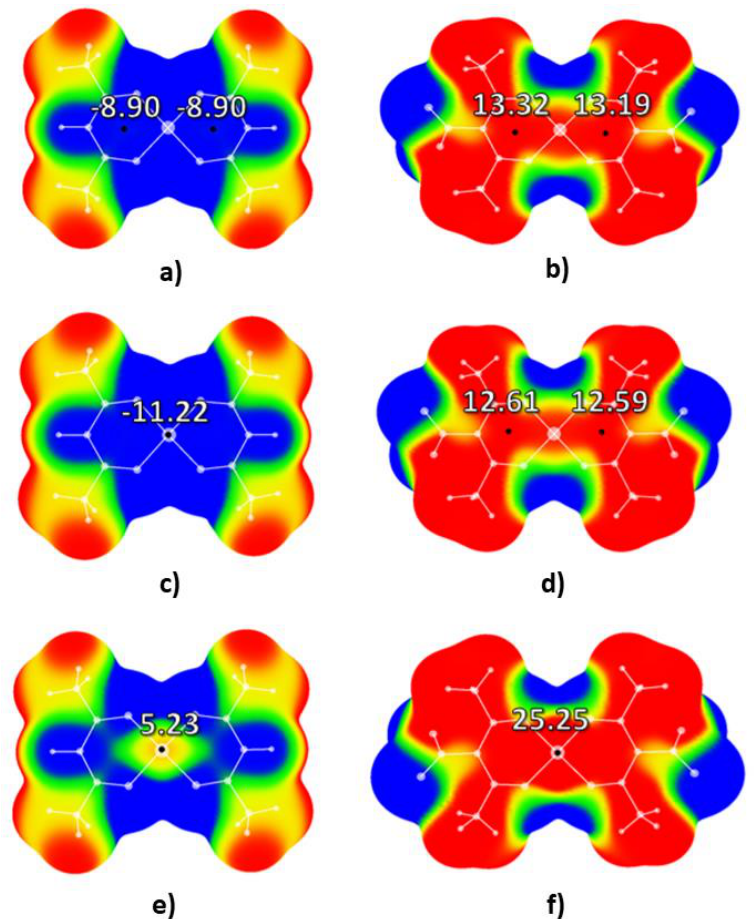
Figure 2. Calculated electrostatic potential maps for: ( a ) bis(acetylacetonato) cobalt (II), ( b ) ni- tro-bis(acetylacetonato) cobalt (II), ( c ) bis(acetylacetonato) nickel (II), ( d ) nitro-bis(acetylacetonato) nickel (II), ( e ) bis(acetylacetonato) copper (II), and ( f ) nitro-bis(acetylacetonato) copper (II) com- plexes. Values of energies in critical points are provided in kcal/mol. Color ranges, in kcal/mol, are: red, greater than 6.28, yellow, from 0.00 to 6.28, green, from −6.28 to 0.00, and blue, more negative than −6.28. Black dots represent critical points on the molecular surfaces.